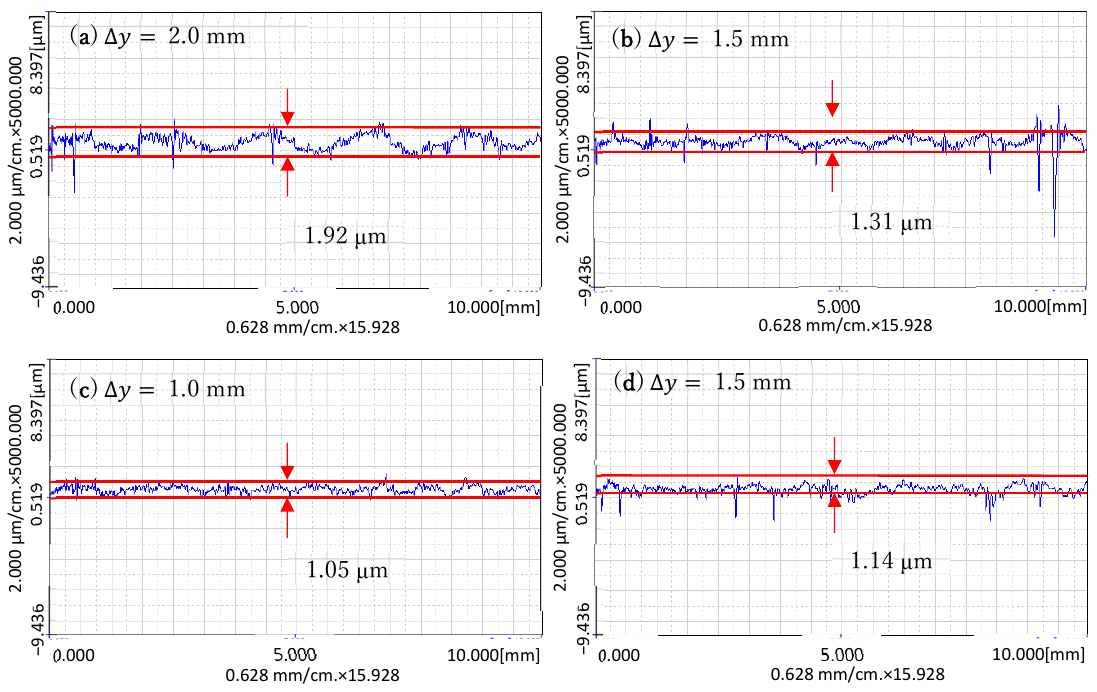
Figure 18. The cross-section curves of the surface along the y -direction after processing: ( a ) The cross-section curves at ∆y = 2.0 mm; ( b ) The cross-section curves at ∆y = 1.5 mm; ( c ) The cross-section curves at ∆y = 1.0 mm; ( d ) The cross-section curves at ∆y = 0.5 mm.